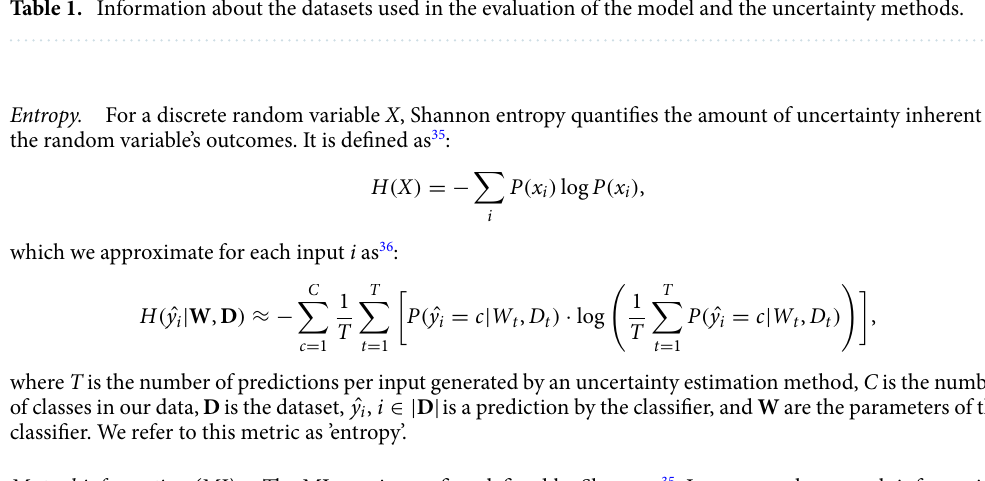
Table 1. Information about the datasets used in the evaluation of the model and the uncertainty